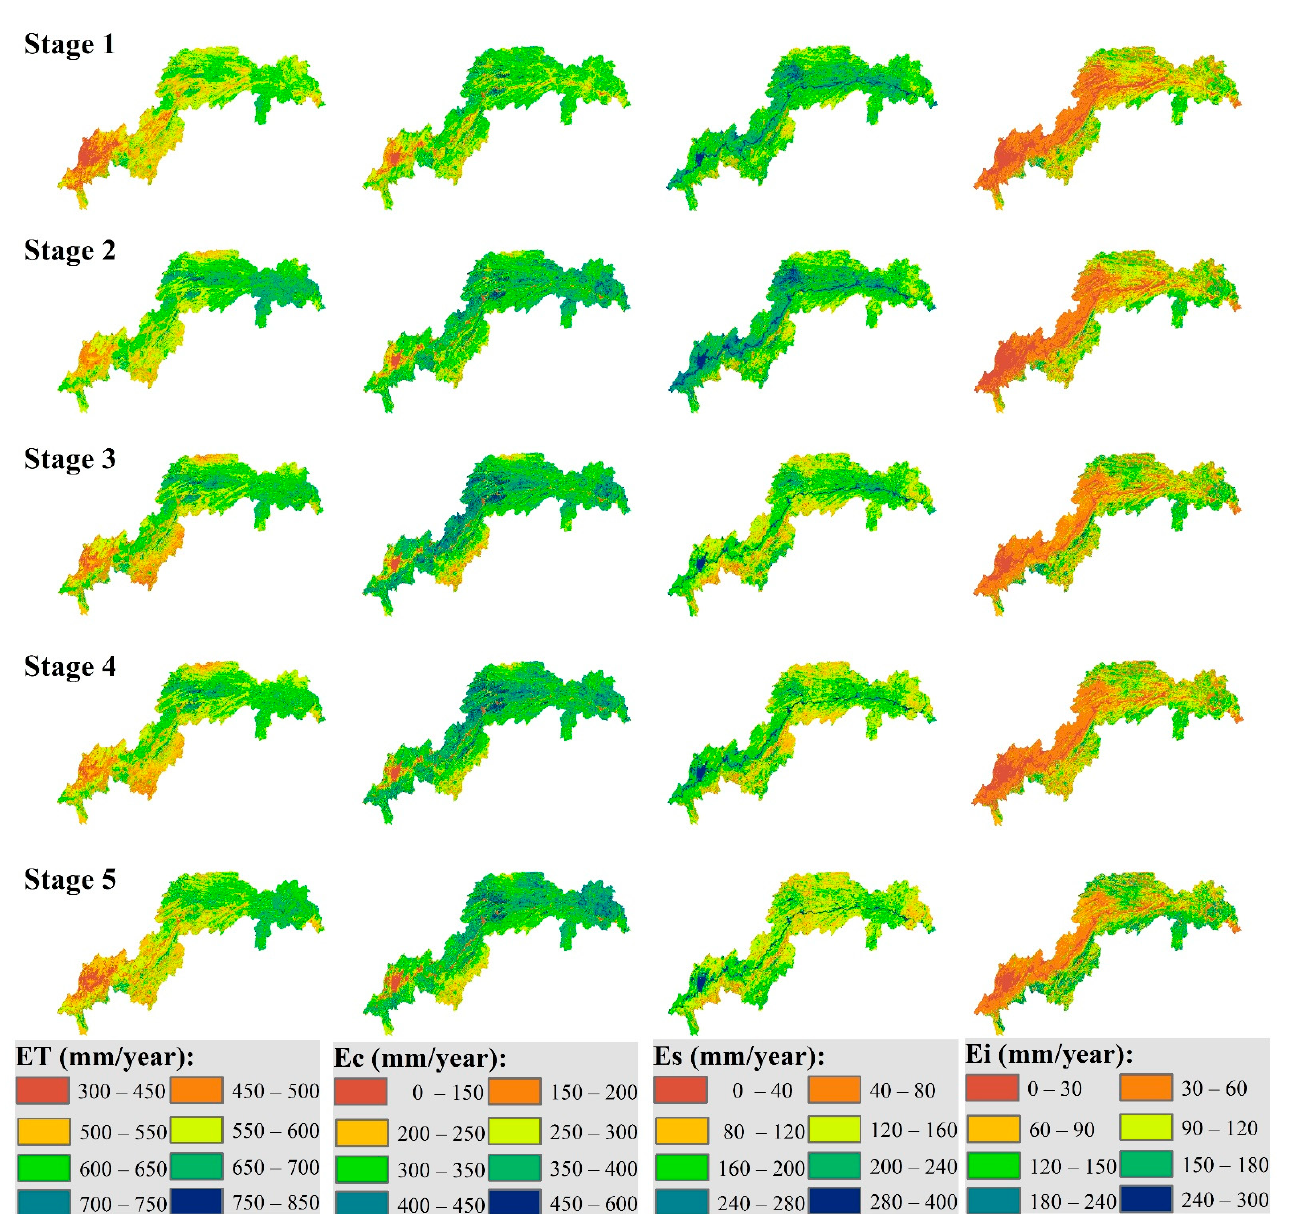
Figure 5. The spatial distribution of annual ET, Ec, Es, and Ei during different impoundment periods.